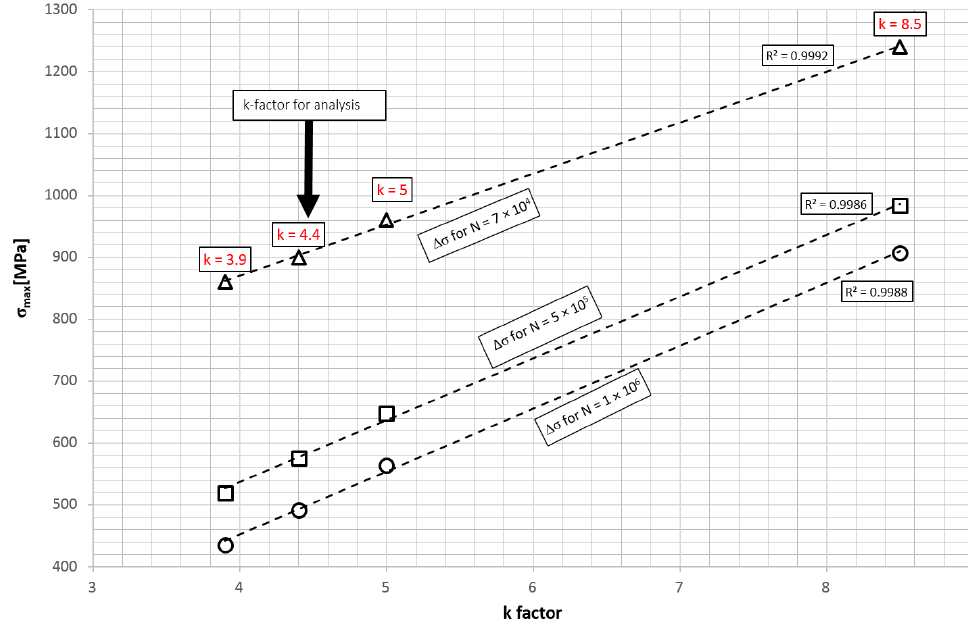
Figure 12. Change of maximum stress σ max at constant number of cycles for various k values.